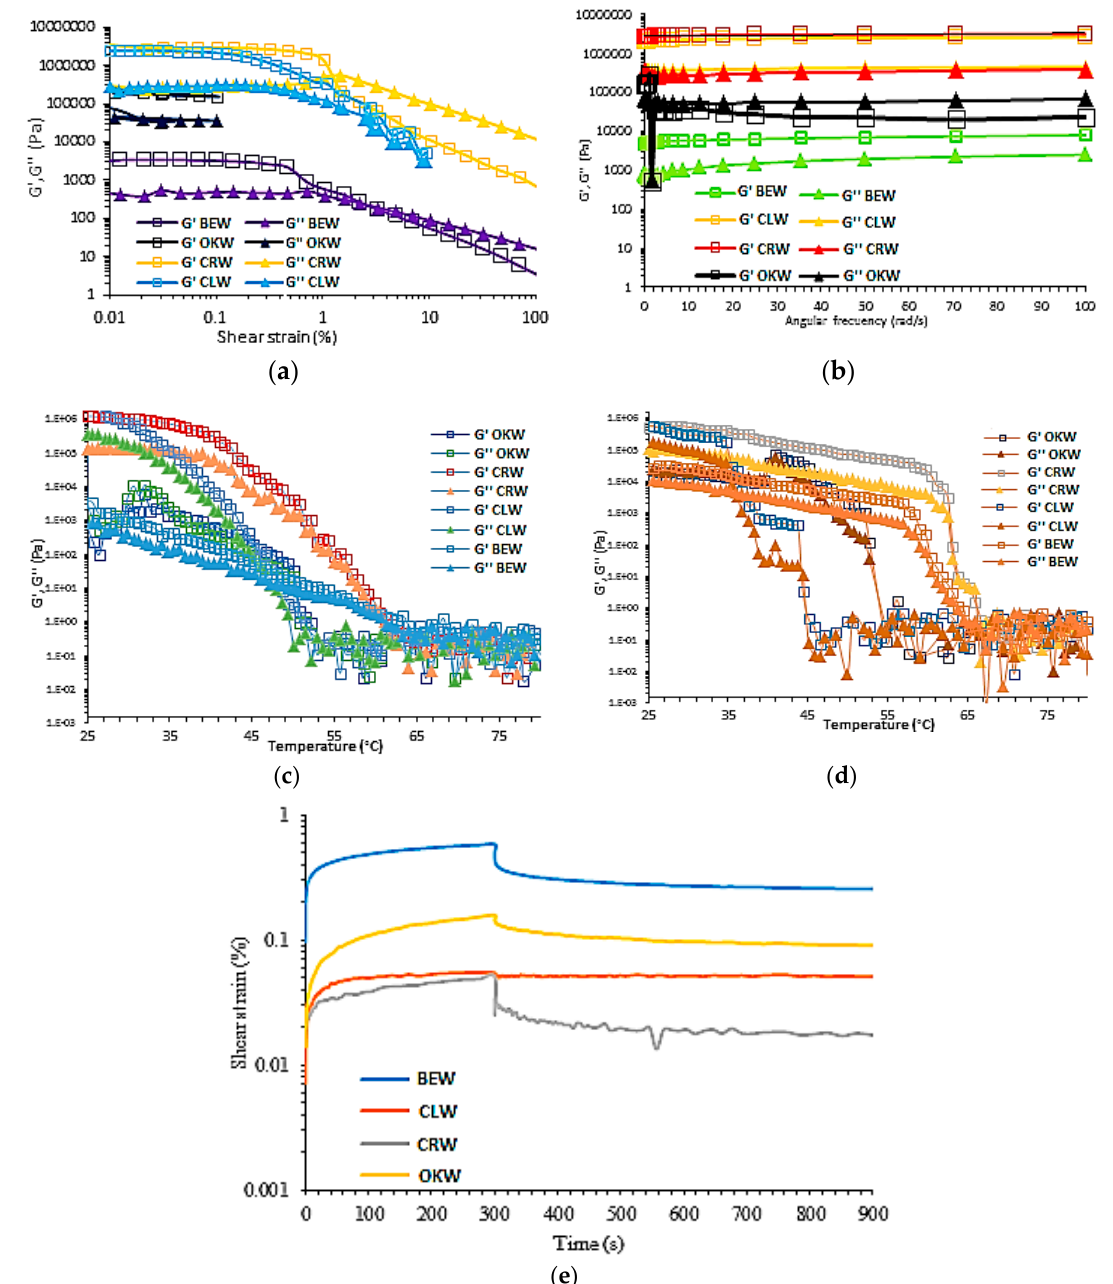
Figure 3. Linear viscoelastic region ( a ); frequency sweep curves ( b ); heating temperature sweep ( c ); cooling temperature sweep ( d ); creep test of matrix systems ( e ); produced with representative waxes: BEW, beewax matrix; CRW, carnauba matrix; CLW, candelilla matrix; OKW, ozokerite matrix. Table 3. Viscoelastic parameters obtained from the oscillation yield strain, frequency and temperature sweep tests.